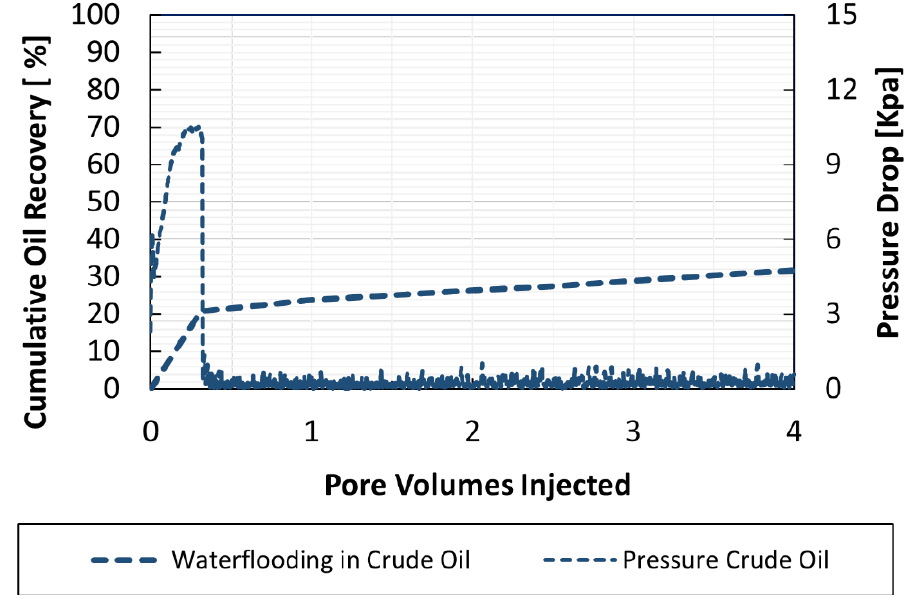
Figure 6. Crude oil displacement by waterflooding at 0.3 mL/min.